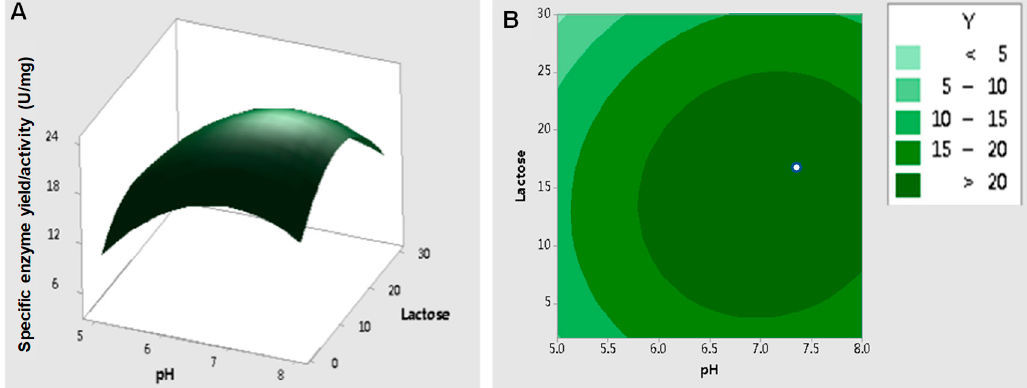
Figure 8. Response surface effects of the pH and concentration of lactose on the specific enzyme activity of β -galactosidase. ( A ) Three-dimensional response surface plots; ( B ) contour plots showing the predicted optimal response. The data were analyzed by Minitab and determined with 95% confidence from an analysis of variance (ANOVA).